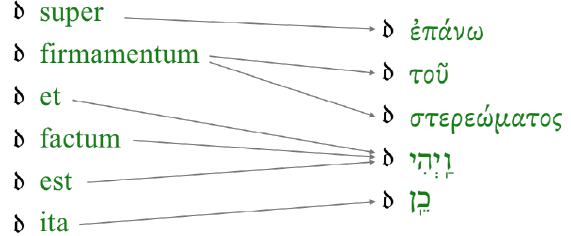
Figure 13: Aligning the Latin with both Greek and Hebrew (Gen